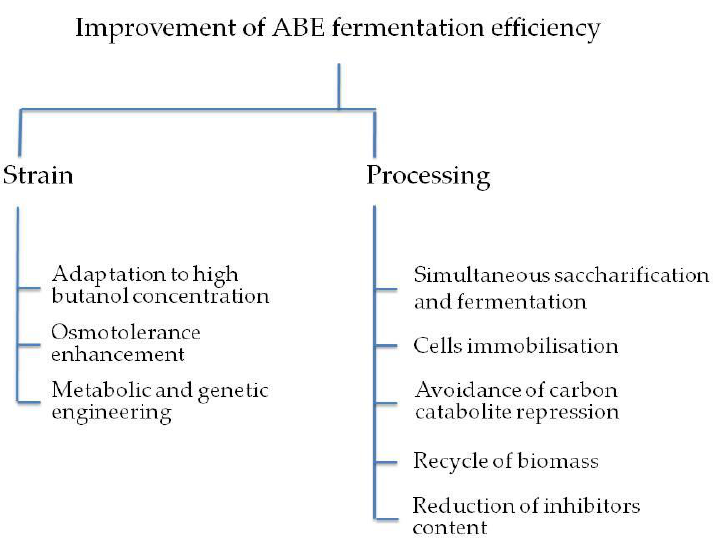
Figure 1. Improvement strategies for biobutanol production.